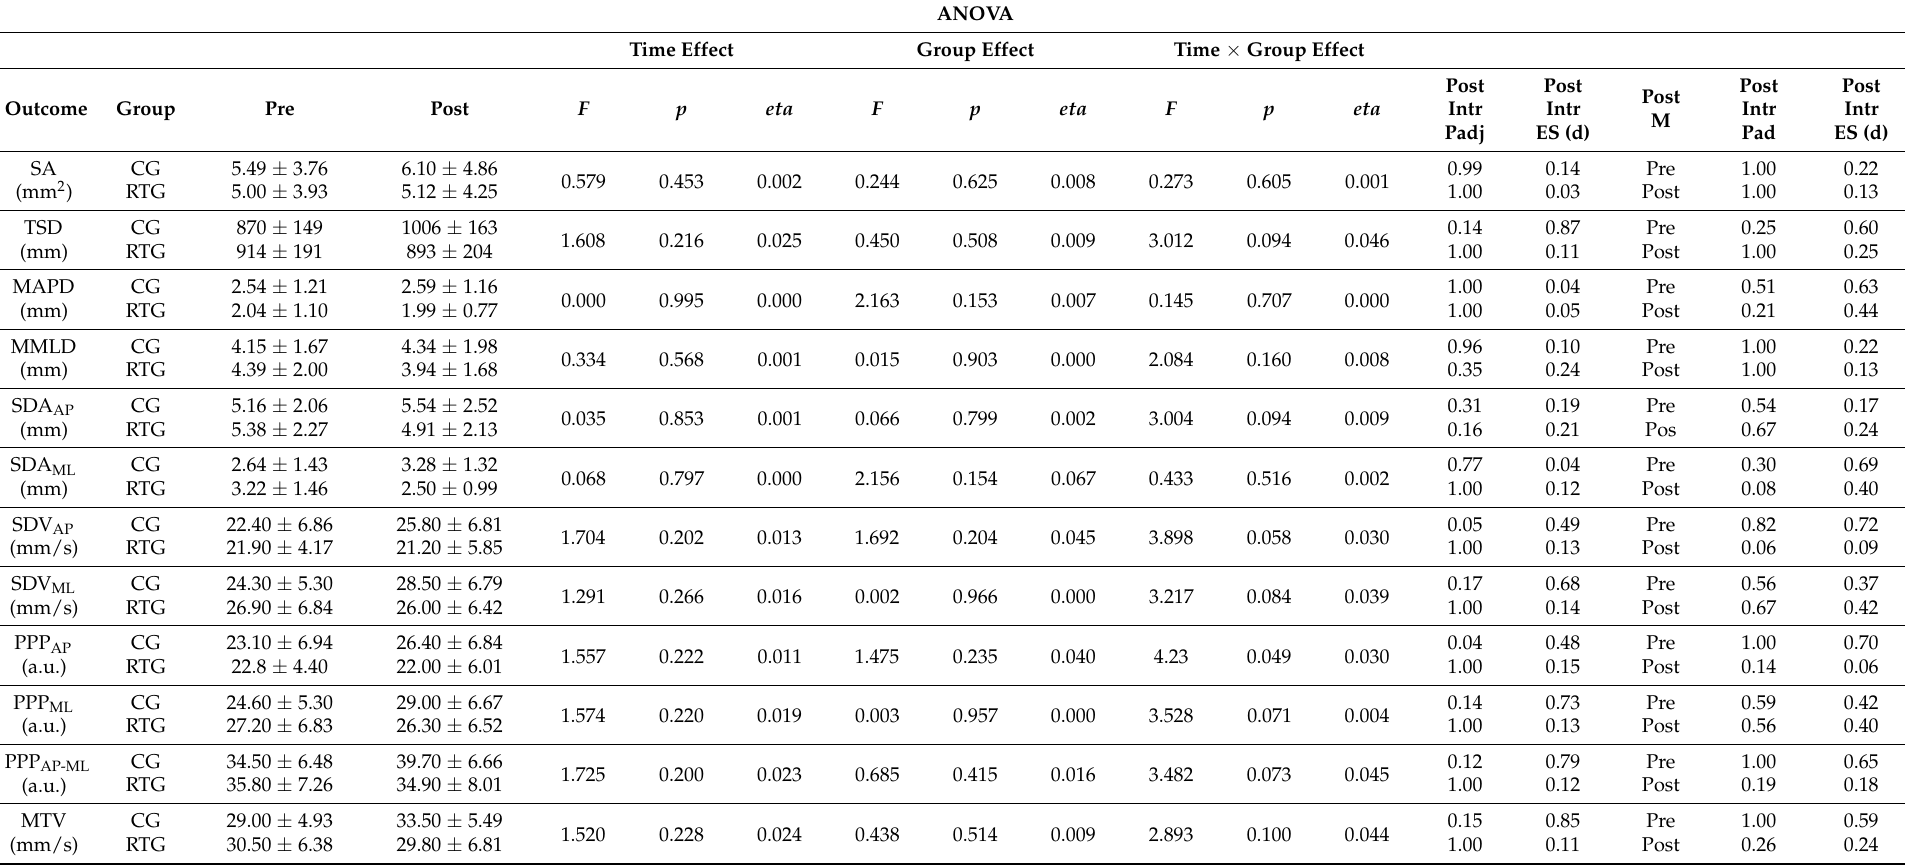
Table 6. Eyes-open balance